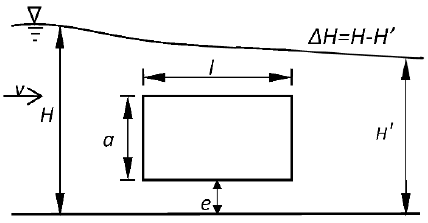
Figure 1. The parameters of combined orifice-weir flow.